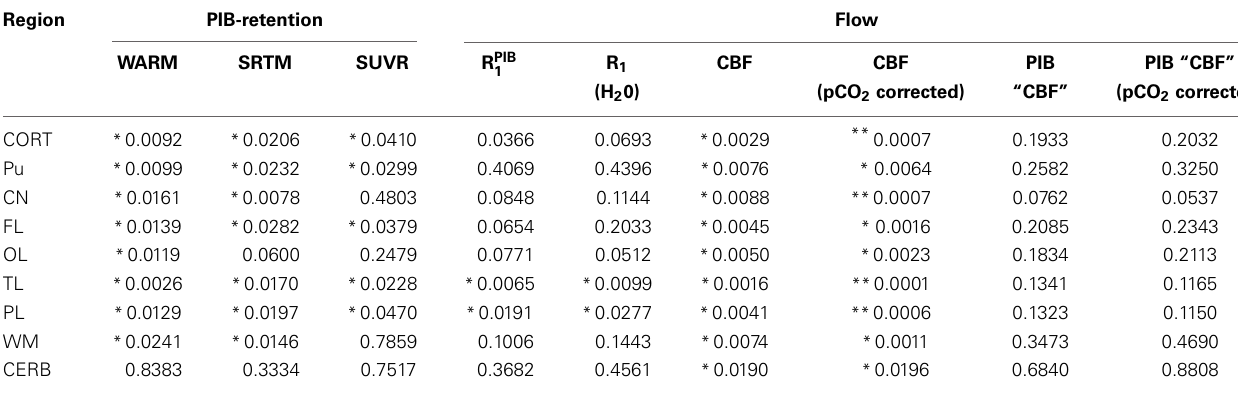
Table 1 | Regional statistical significance (student t -test) between AD vs. HC subject values for both [ 11 C ] PIB retention and flow estimates ( ∗ p < 0 . 05) ( ∗∗ p < 0 . 001).